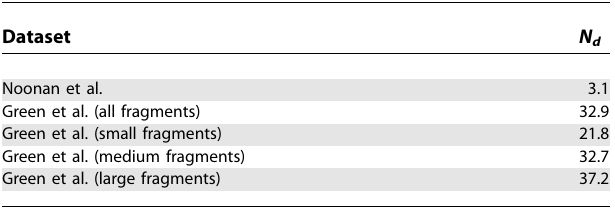
Table 1. N d Values for the Noonan et al. [1] and Green et al. [2] Datasets